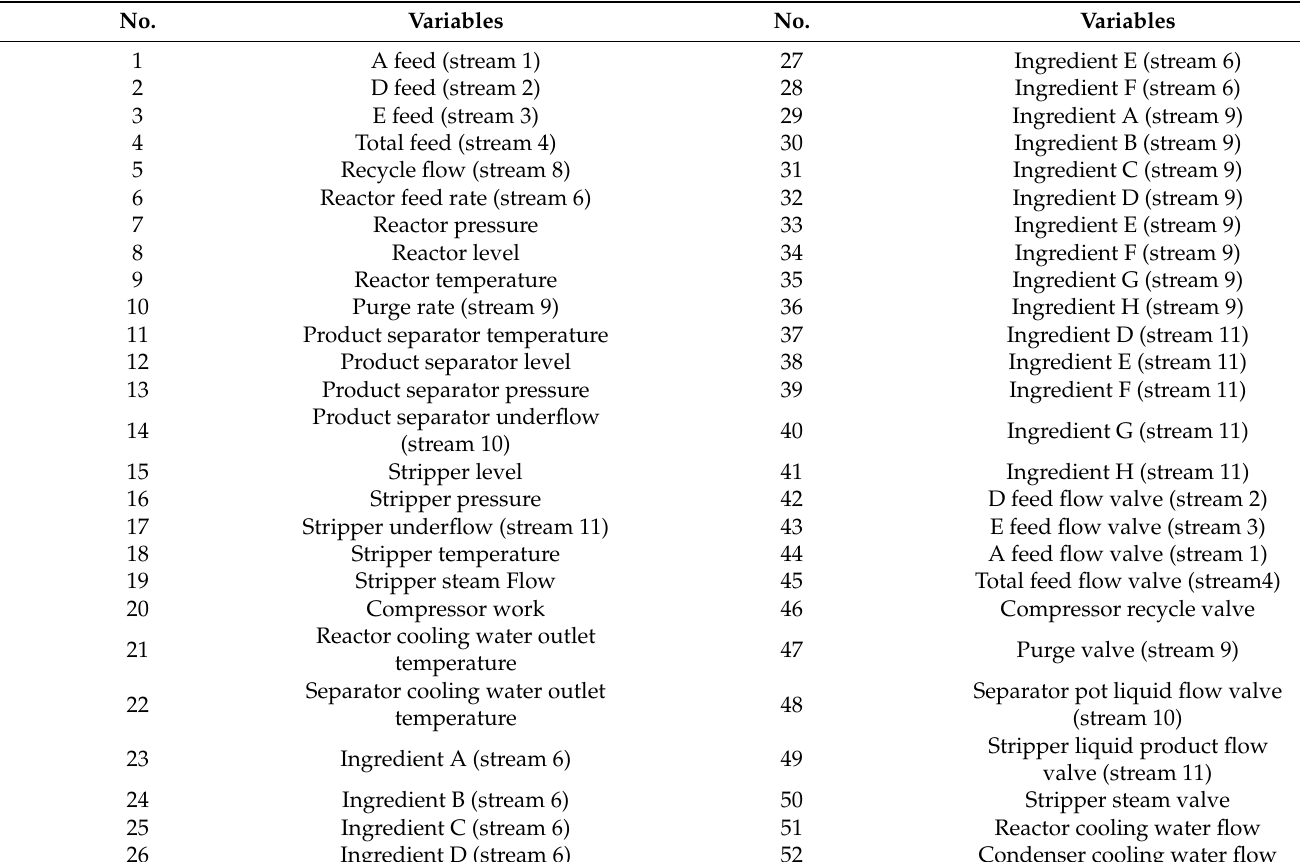
Figure 7. TE process. Table 1. Process monitoring variables in the Tennessee Eastman process.